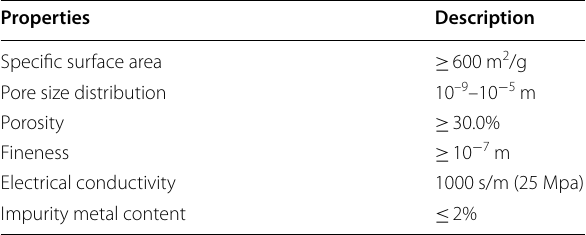
Table 2 Properties of three-dimensional graphene.